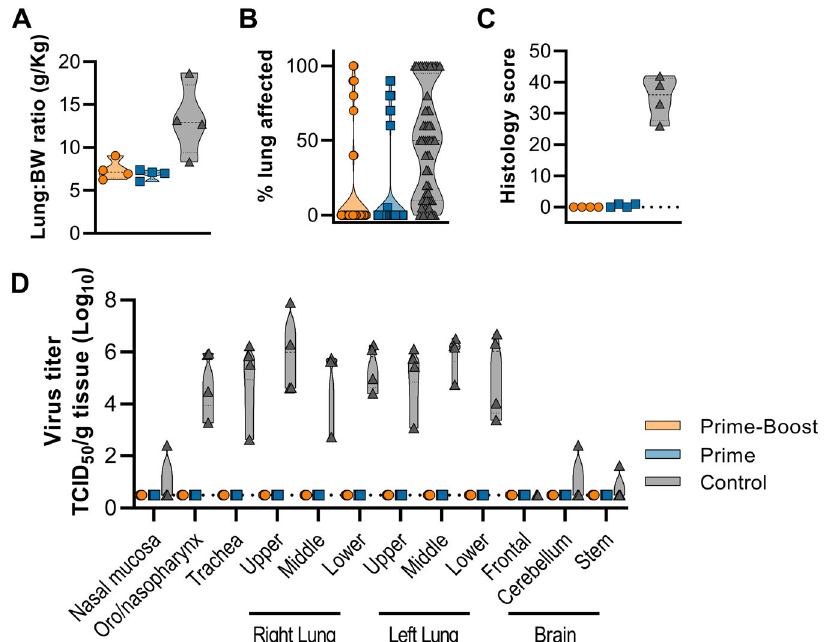
Fig. 3 No evidence of NiV infection detected in vaccinated animals. AGMs were euthanized when a clinical score of 35 was reached (all control animals, 5 – 7 DPI) or on 42 DPI (all vaccinated animals). A Truncated violin plot of lung:body weight (BW) ratio. B Truncated violin plot of percentage of gross lung lesions. which were scored for each lung lobe, ventral and dorsal. C Truncated violin plot of histology score. All six lung lobes were scored and cumulative score is shown per animal (maximum score = 90). D Truncated violin plot of infectious virus detected in respiratory tract and brain tissue. For all panels, orange indicates prime-boost vaccinated animals, blue indicates prime-only vaccinated animals, and gray indicates control animals. No statistical tests were performed since samples were obtained on different days post